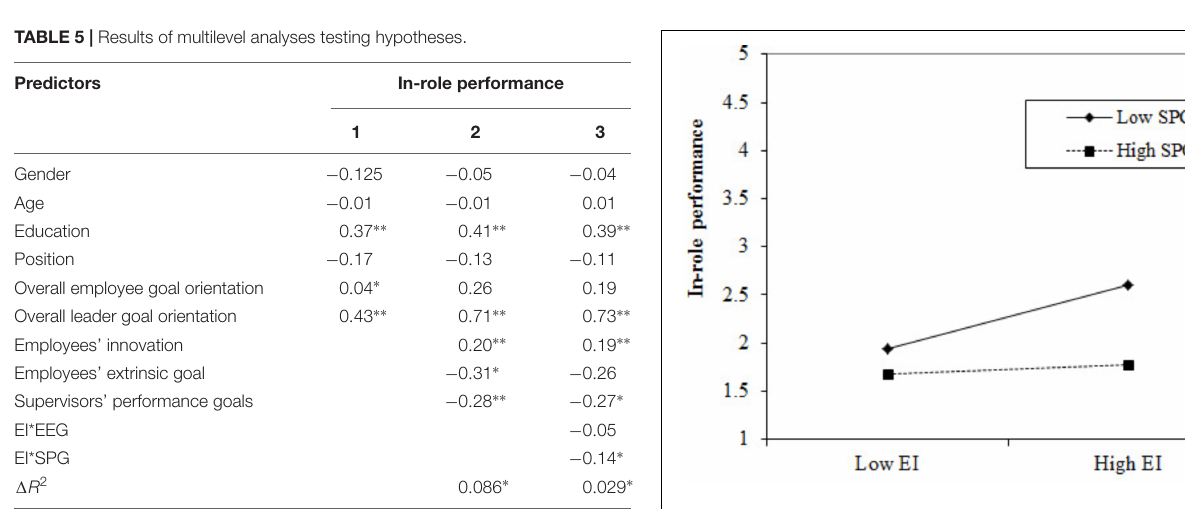
FIGURE 2 | Two-way interaction effects of El by SPG on employee in-role